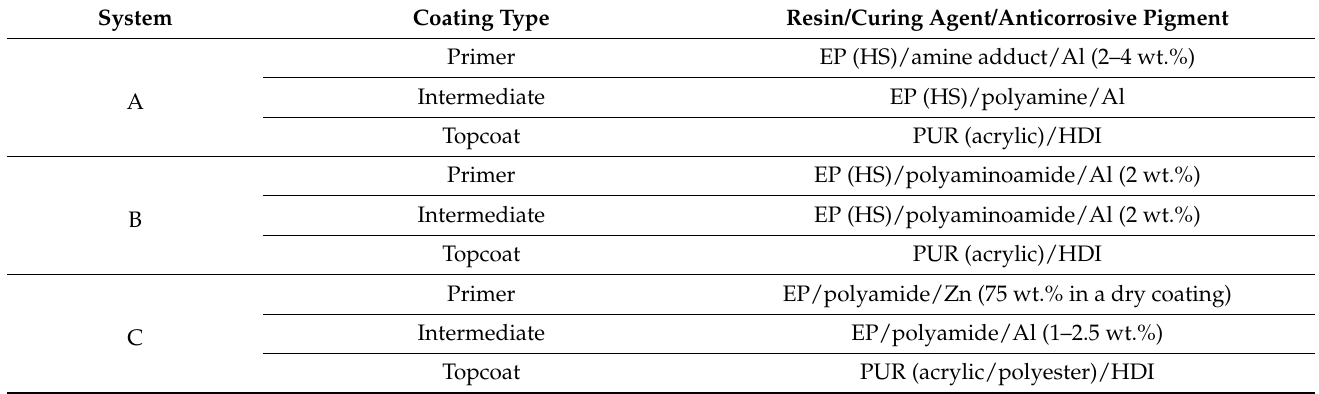
Table 2. Types of applied coating